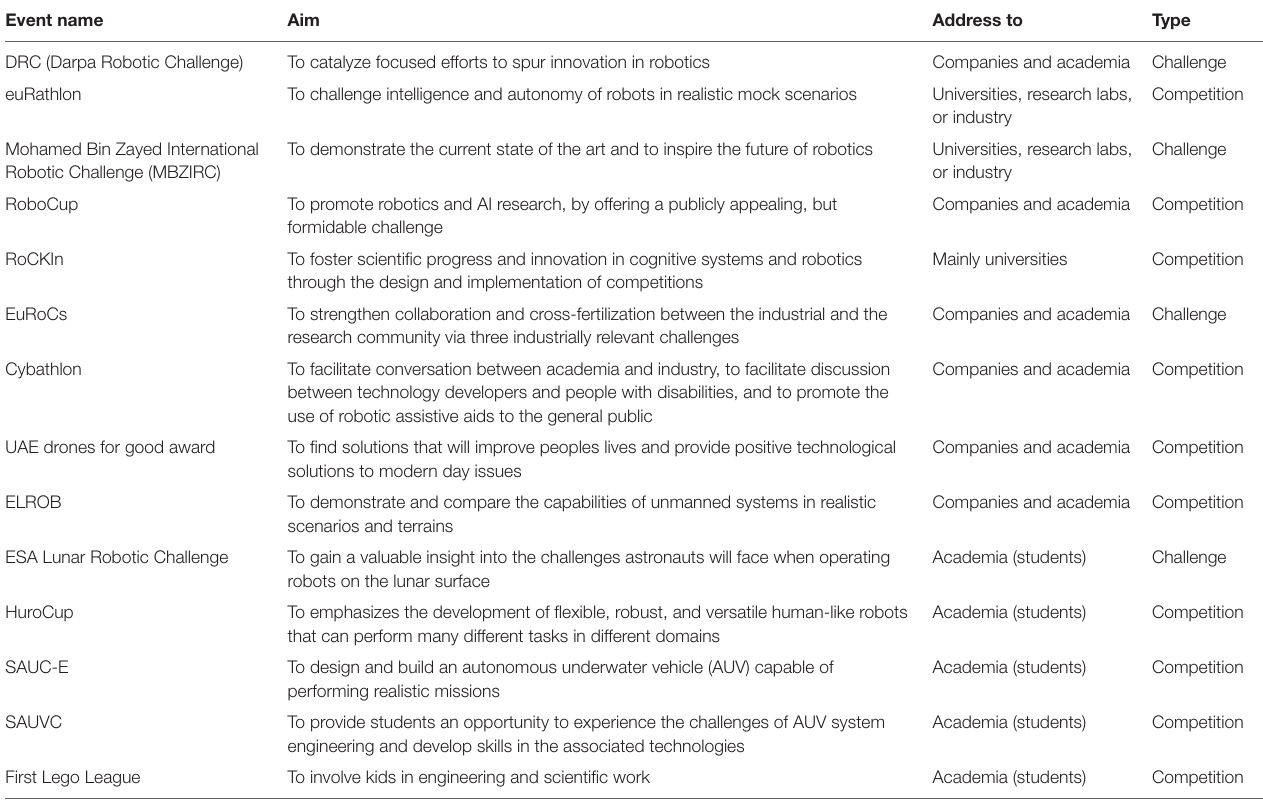
tABLe 1 | A list of events related to robotics, with the aims declared by organizers, labeled as challenges and competitions. event